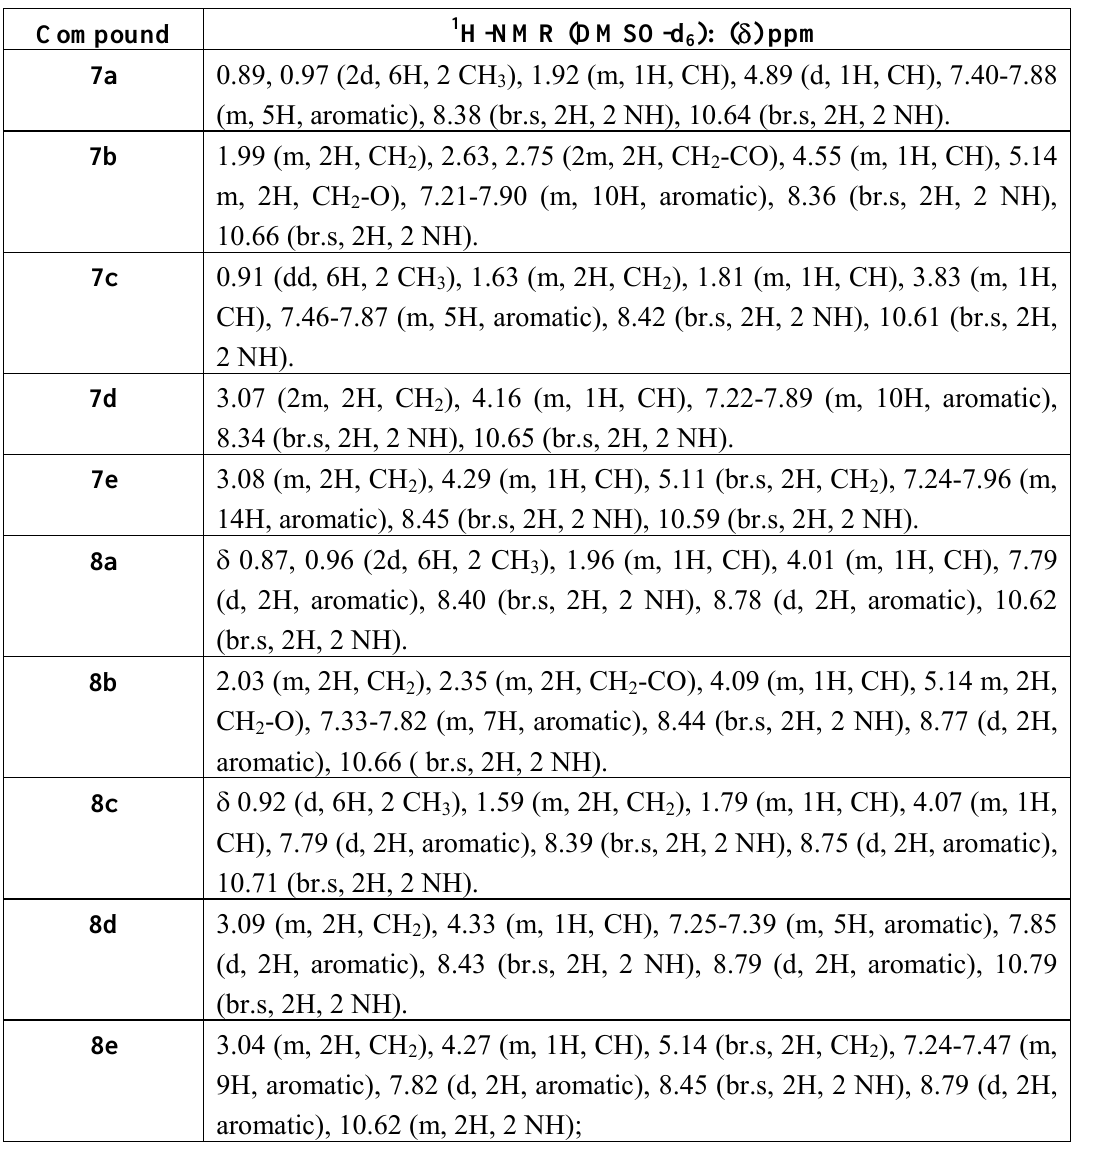
Table 2. 1 H-NMR Data of Compounds 7 and 8